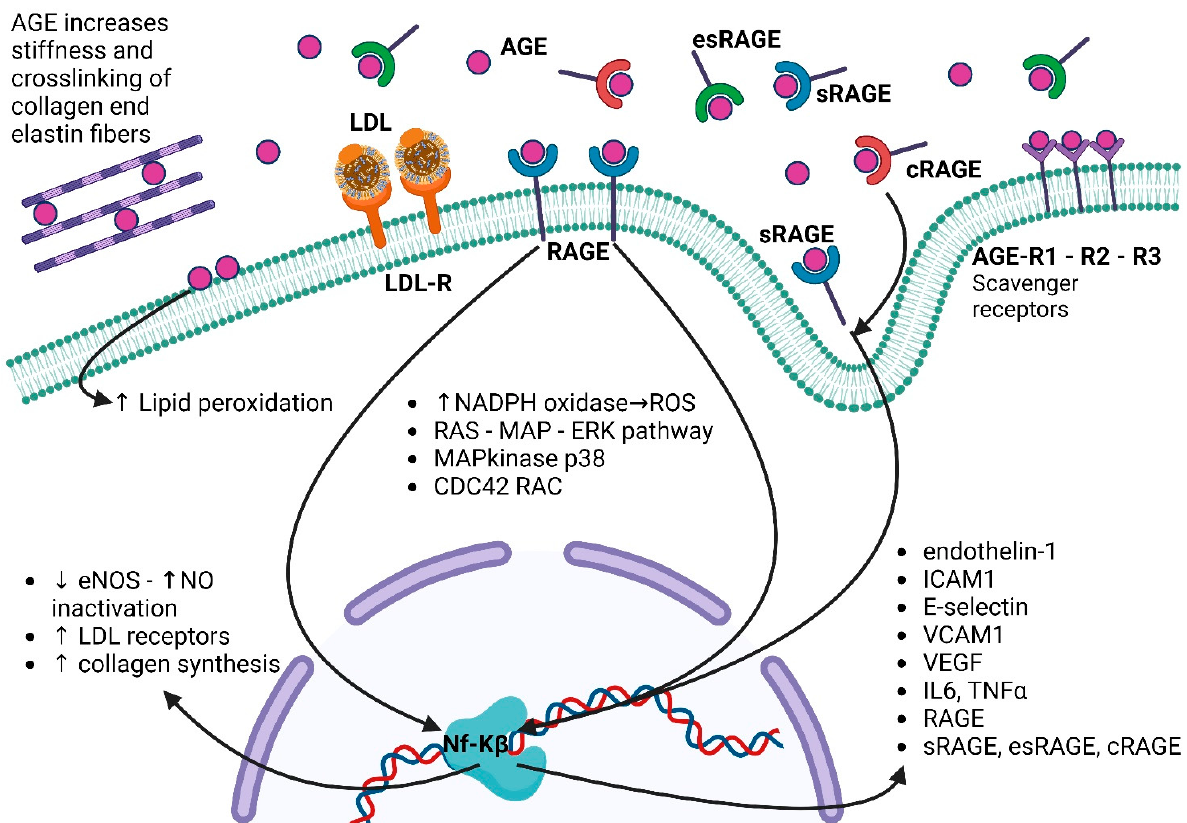
Figure 2. AGE–RAGE interaction at the intracellular level and RAGE activation cascade. Note: In the ECM, AGEs form on several different molecules, including lipids, collagen, laminin, elastin, and vitronectin. The formation of AGEs on ECM molecules impairs the constitution of the matrix and increases its stiffness. AGEs that bind to RAGEs on the cell surface begin a signaling cascade, stimulating NAD(P)H oxidase and increasing ROS, p21 RAS, and MAPKs. The ligand–RAGE interaction may also stimulate signaling via p38 MAPK and Rac/Cdc. A key target of RAGE signaling is Nf- κ B. Nf- κ B is translocated to the nucleus, where it promotes transcription of several proteins, including endothelin-1, ICAM-1, E-selectin, and tissue factor. Moreover AGE–RAGE interaction stimulates the synthesis of sRAGE (soluble receptor for advanced glycation end products), cRAGE (cleaved receptor of advanced glycation end products), and esRAGE (endogenous spliced receptor of advanced glycation end products). AGE and ligands for RAGE, sRAGE, and cRAGE trigger inflammatory response, while esRAGE serves as a scavenger molecule for circulating AGEs. AGEs seem to lower NO availability by decreasing activity of NOS and by quenching